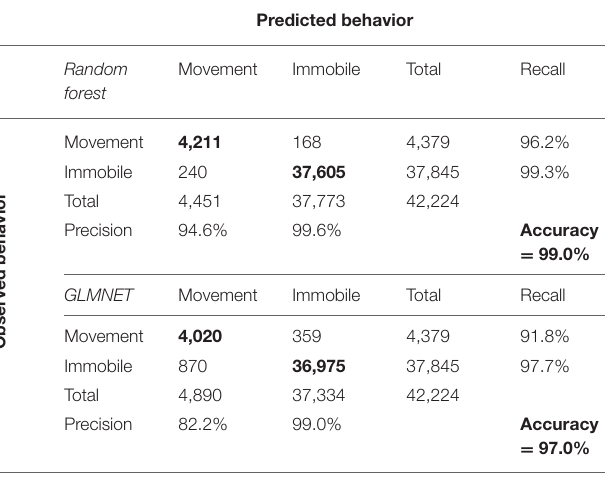
TABLE 2 | Confusion matrix for the Random Forest and Generalized Linear Mixed-NET (GLMNET) models. Predicted behavior Random